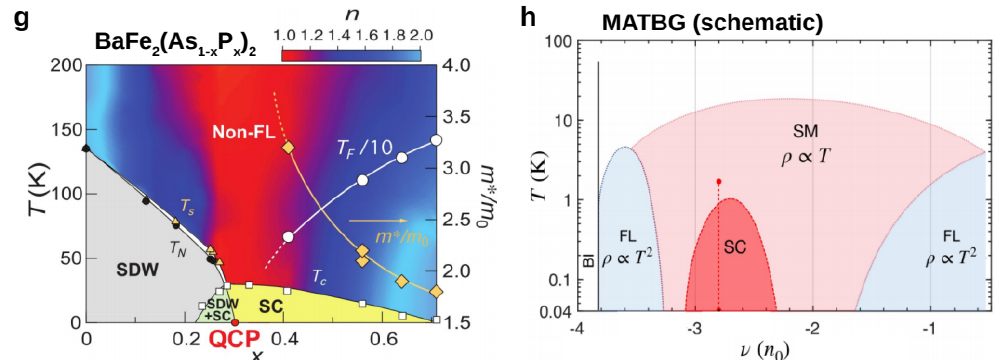
Figure 1. Color-coded phase diagrams featuring strange metal behavior in various materials plat- forms. ( a ) YbRh 2 Si 2 ( left ) and YbRh 2 (Si 0.95 Ge 0.05 ) 2 ( right ), from [40]. ( b ) CeRu 2 Si 2 , from [41]. ( c ) CeRhIn 5 , from [42]. ( d ) Ce 3 Pd 20 Si 6 , from [43]. ( e ) SrRu 3 O 7 . Note that the temperature scale is cut at 4.5K. At lower temperatures, deviations from linear behavior towards larger powers are observed; from [44]. ( f ) La 2 − x Sr x CuO 4 , from [45]. ( g ) BaFe 2 (As 1 − x P x ) 2 , from [46]. ( h ) Magic-angle twisted bi-layer graphene, adapted from